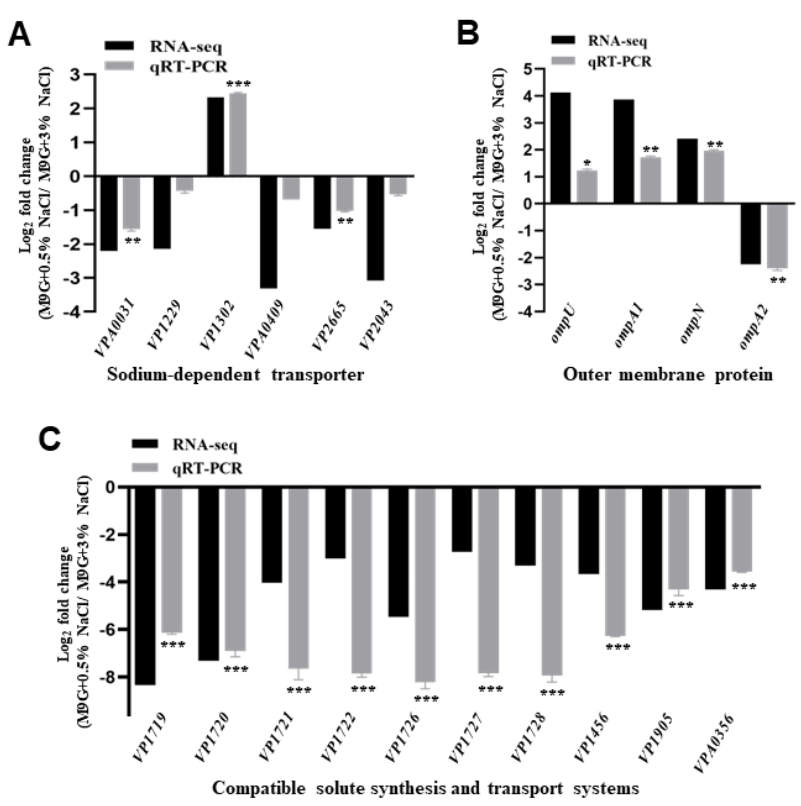
Figure 3. The transcript levels of putative osmoadaptation systems in V. parahaemolyticus . RNA-seq and qRT-PCR analysis for the transcription levels of the sodium-dependent transporter ( A ), outer membrane proteins ( B ), and compatible solute synthesis and transport systems ( C ). The data are presented as the mean ± standard deviation (SD) (n = 3). * p < 0.01, ** p < 0.001, *** p < 0.0001, Student’s t -test.